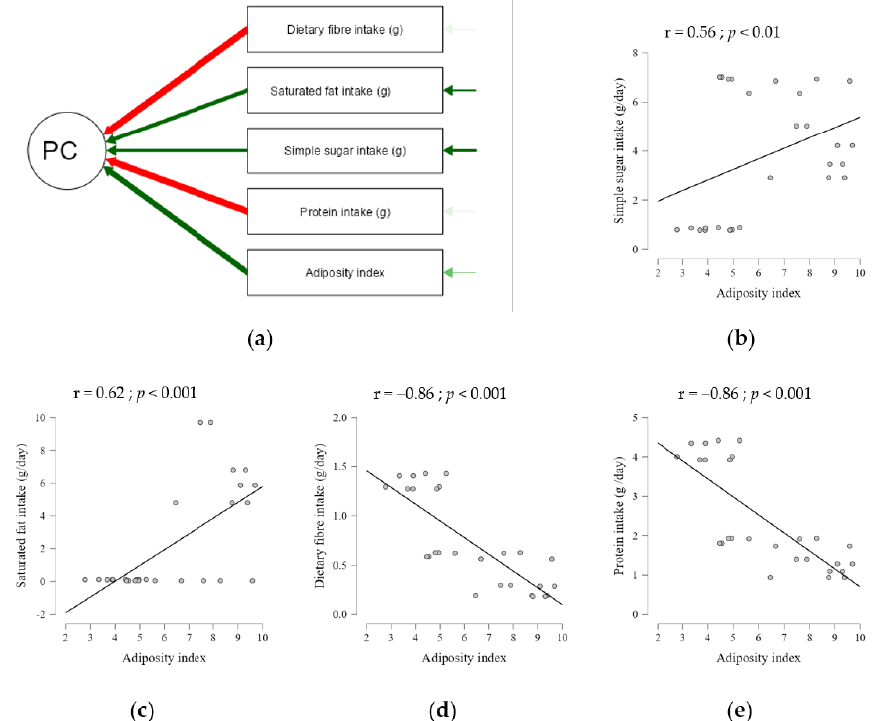
Figure 2. Correlation between nutrients intake and adiposity index. ( a ) Path diagram of principal component (PC) used in Pearson correlation analysis. ( b ) Simple sugar and ( c ) saturated fat intakes were positively correlated with adiposity. ( d ) Dietary fibre and ( e ) protein intakes were negatively correlated with adiposity.